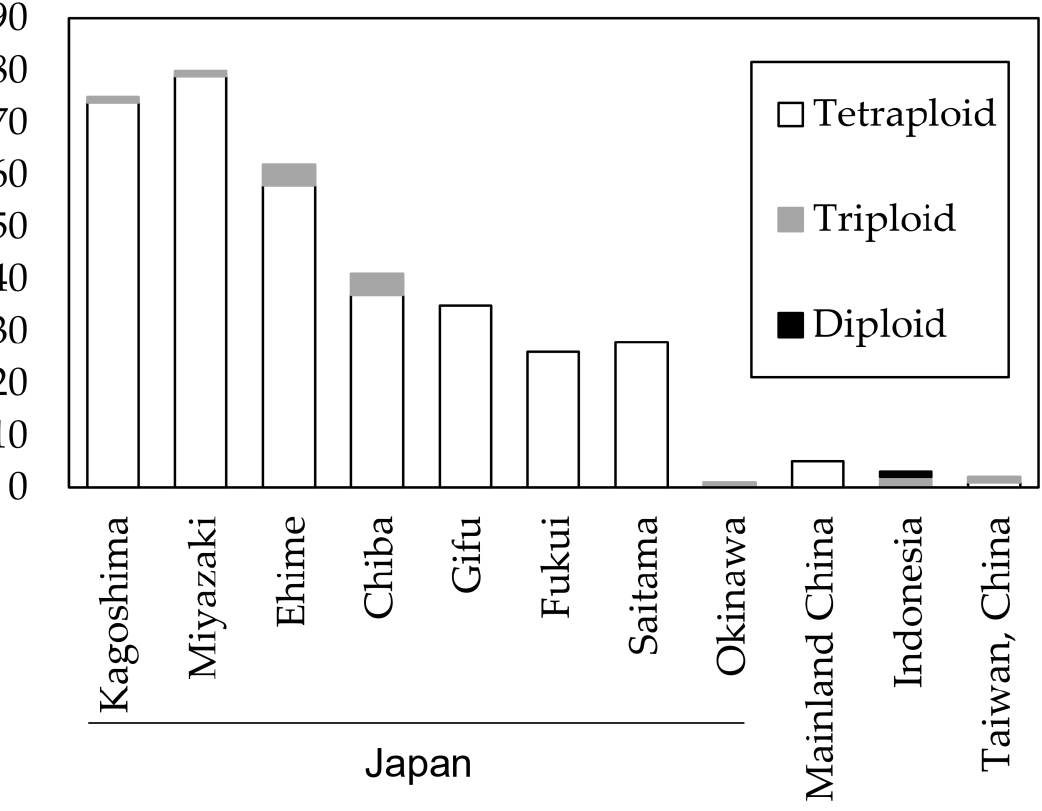
Figure 1. Number of isolates with their ploidy level in each of the 11 populations estimated by the R package “ polysat ” .